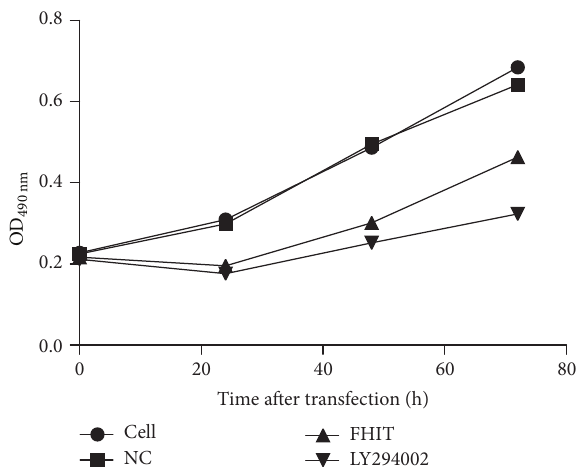
Figure 4: Effect of FHIT overexpression and LY294002 treatment on cell proliferation. OD (optical density) was used to assess cell proliferation at 0, 24, 48, and 72 h after treatment with LY294002 or